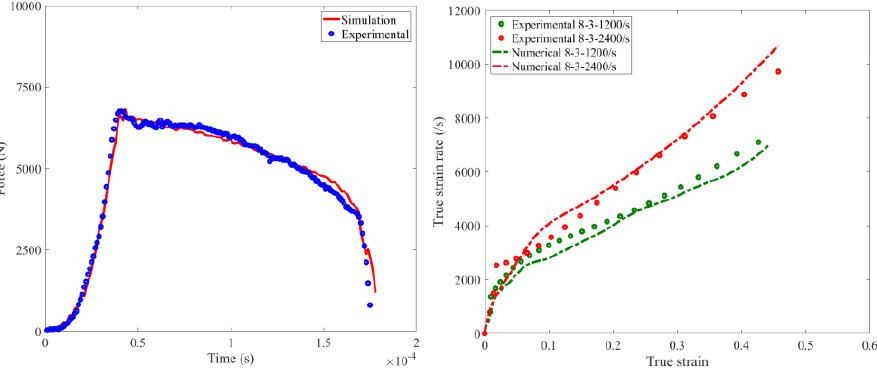
Fig. 6 Comparison of (a) macro force history and (b) local strain rate histories between the simulations and experiments at high strain rates at 25 °C for Ti3Al2.5V